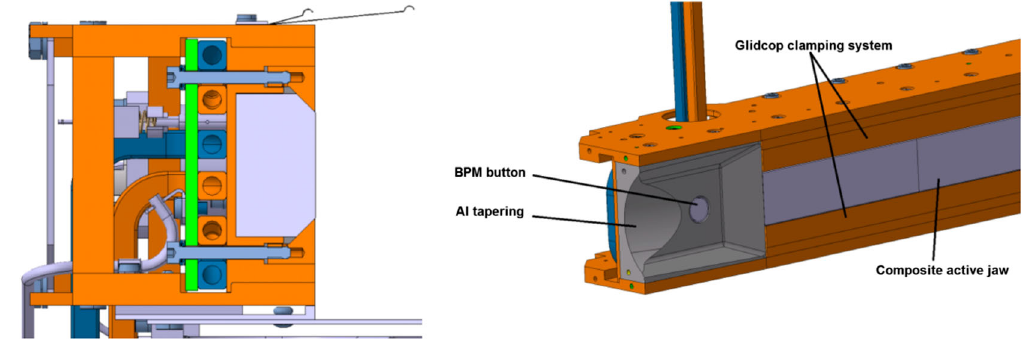
FIG. 25. New collimator modular design of collimator jaw